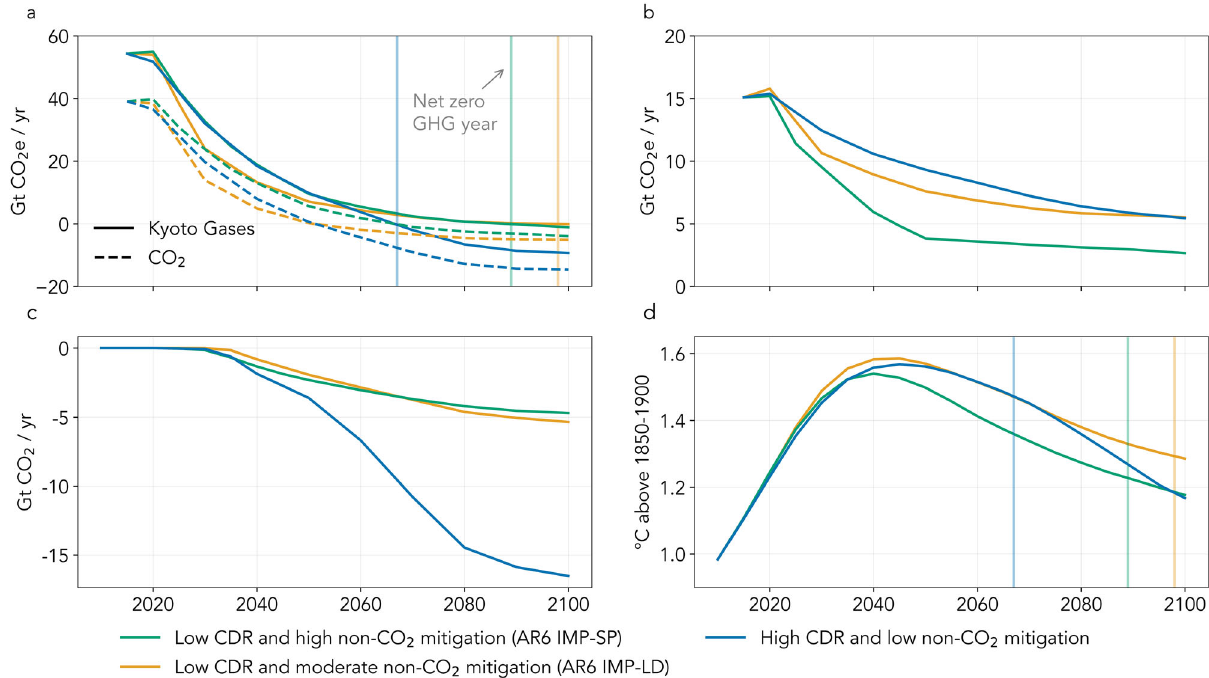
Fig. 4 Illustrative pathways that achieve the three criteria for Paris Agreement consistency. a Kyoto greenhouse gas and CO 2 emissions in Gt CO 2 /yr and CO 2 /yr respectively. The years when net zero greenhouse gas emissions are reached are indicated by vertical lines. b Non-CO 2 emissions aggregated using AR6 GWP100. c Total carbon dioxide removal deployed. d Median temperature rise assessed using MAGICC7. As in ( a ), colored vertical lines denote net-zero GHG timings for the different pathways. The AR6 IMP-SP and IMP-LD refers to two of three illustrative C1 pathways that were highlighted in the AR6 WG III SPM. The remaining illustrative pathway (IMP-Ren) does not meet Criterion III (net zero greenhouse gas emissions). While the IMP-LD does not meet Criterion II, it misses this criteria by just about 1% points and we include it for illustrative purposes given the prominence of this scenario 39